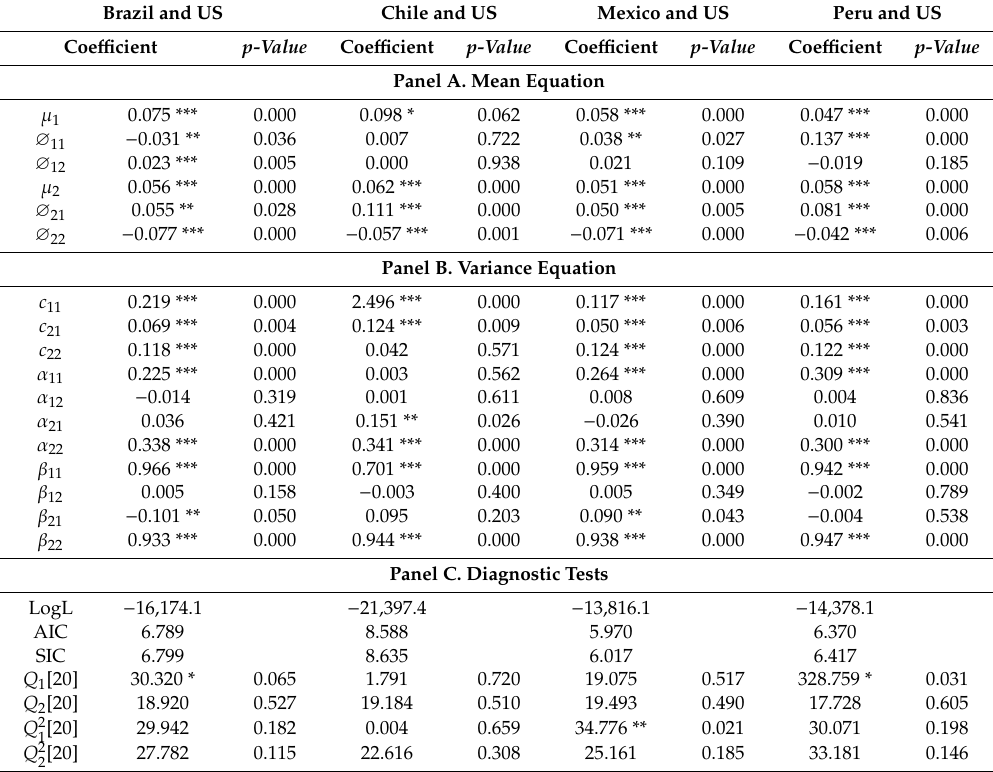
Table 3. Estimates of BEKK-GARCH for the US and Latin American stock markets during the full sample